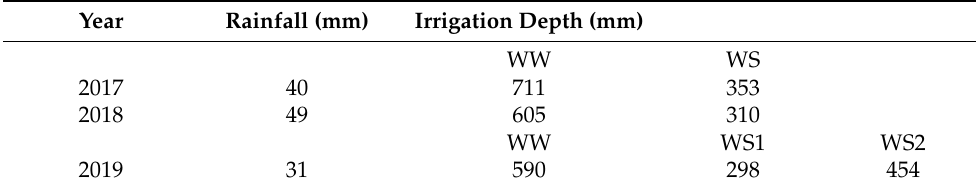
Table 2. Rainfall and supplied irrigation depths during the three experimental growing cycles.